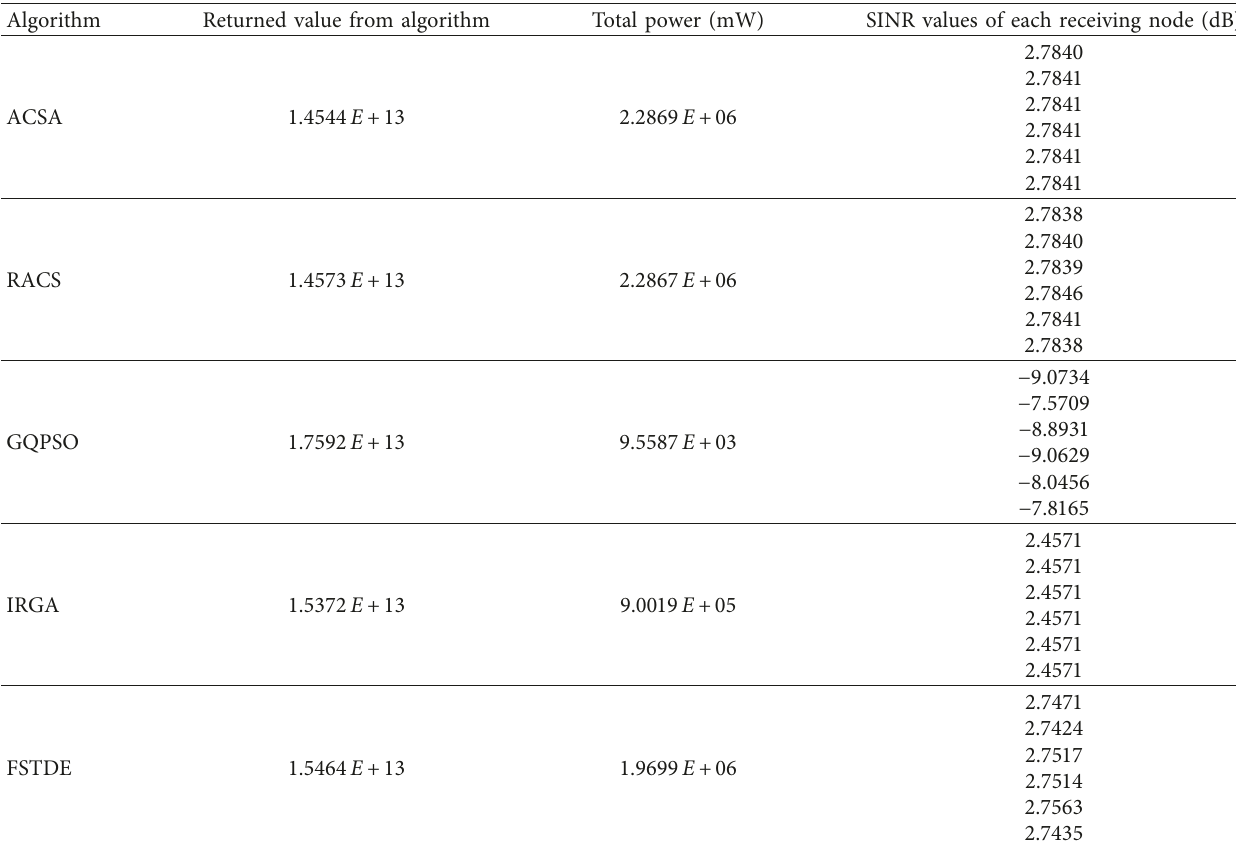
Table 14: Returned results of ACSA and other advanced optimization algorithms for scenario